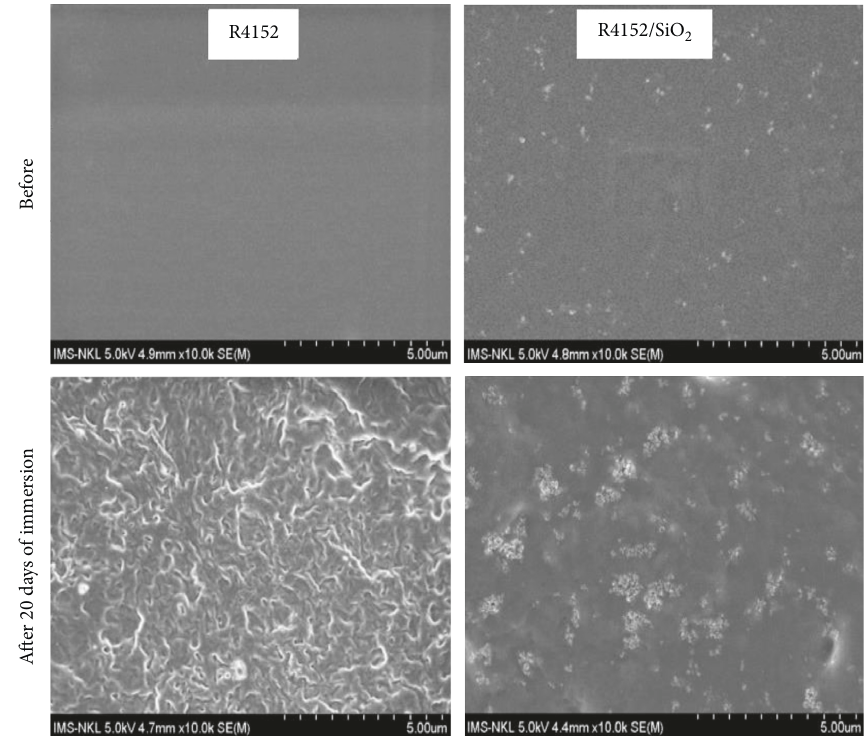
Figure 5: FE-SEM images of the acrylic coating without nano-SiO immersion in the saturated Ca(OH) 2 environment for 20